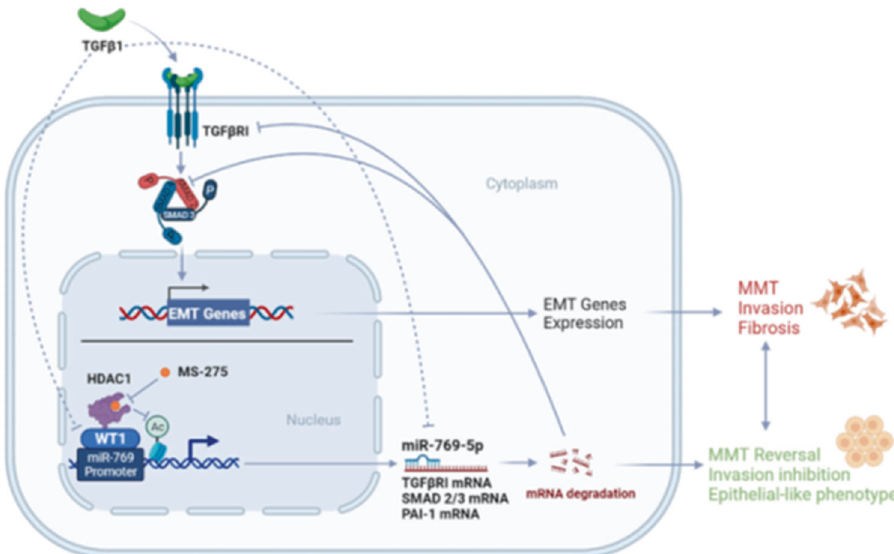
Fig. 7 Both TGF β 1 and HDAC1 limit WT1 activity in mesenchymal-like MCs. In this condition, the anti fi brotic miR-769-5p is downregulated. HDAC1 inhibition may promote MMT reversal through WT1-induced miR-769-5p